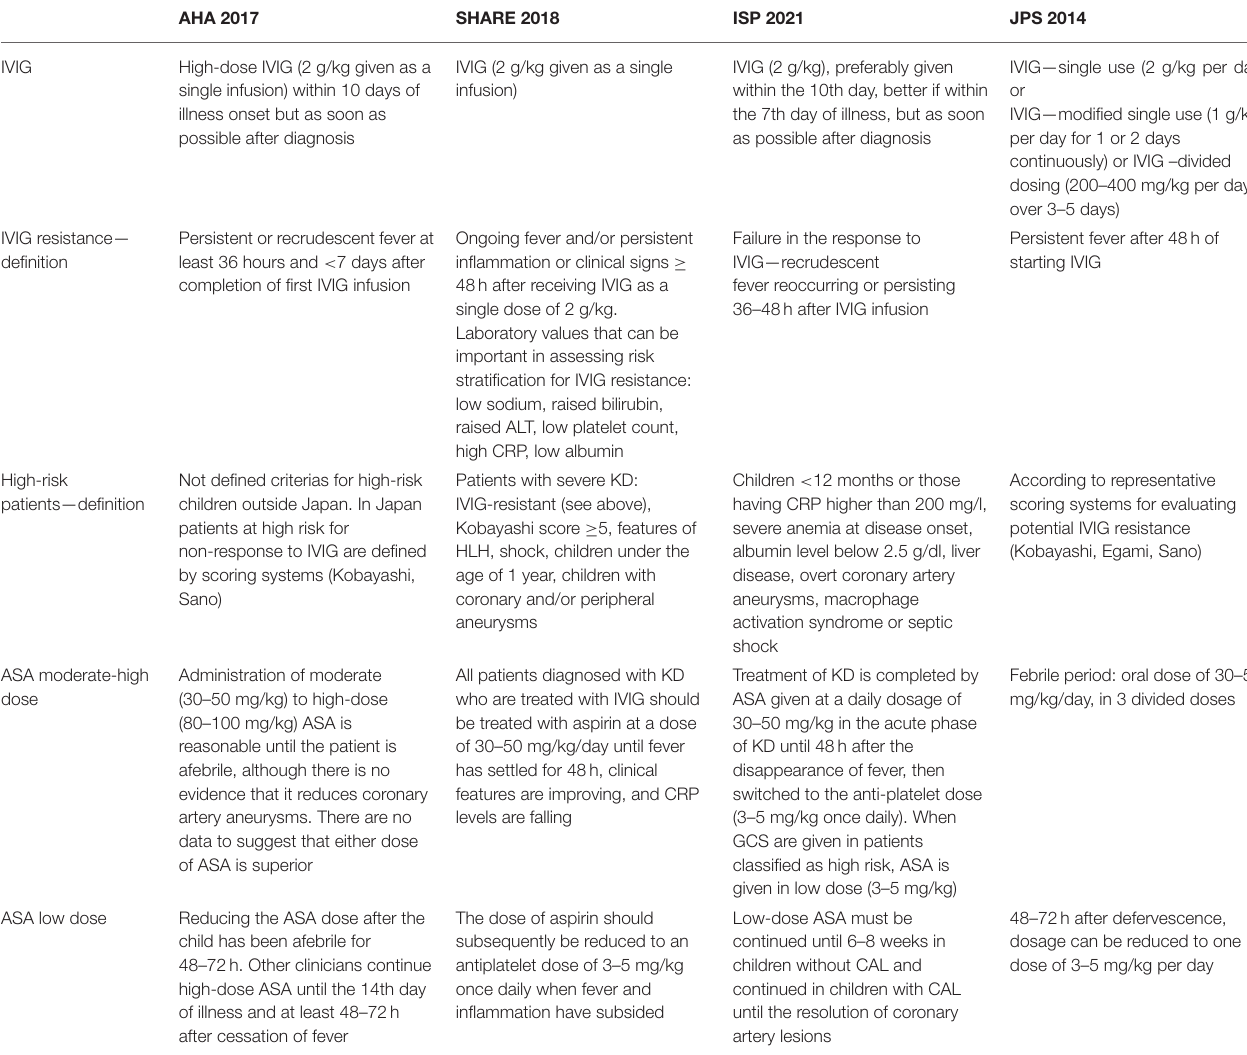
TABLE 1 | Comparison of guidelines for the treatment of Kawasaki